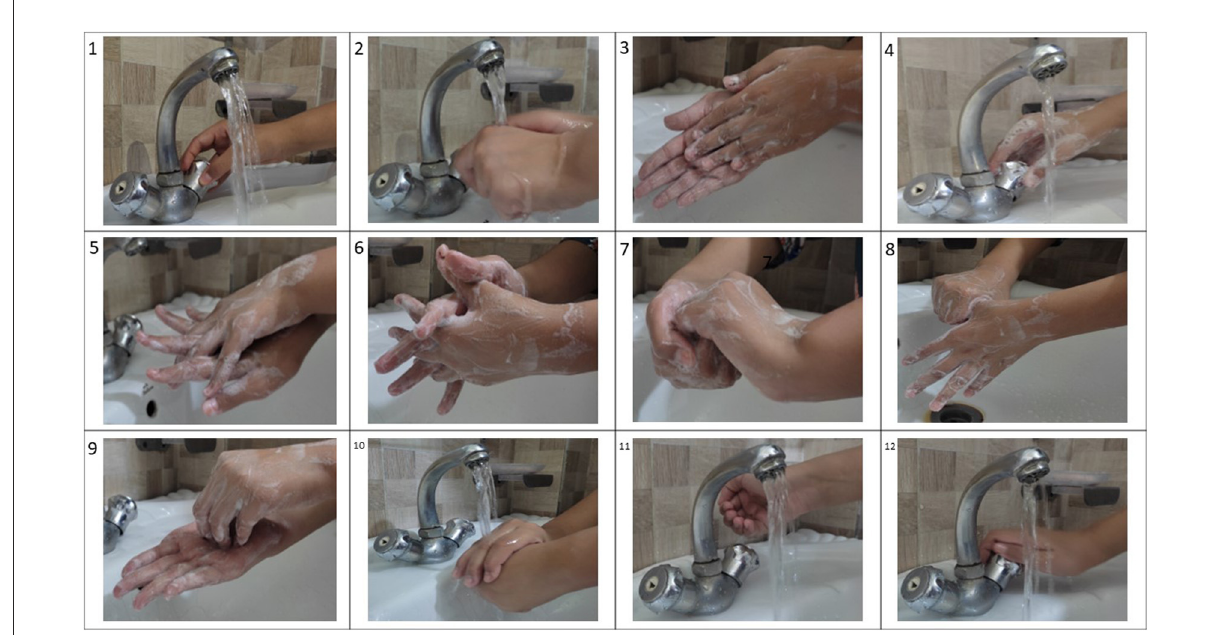
FIGURE1 The steps for the modified hand washing method: 1. open tap, 2. wet hands with water, 3. apply enough soap on hand and rub hands palm to palm to make enough foam, 4. close the tap using the foamed hand evenly applying the foam all over the tap handle/faucet, 5. rub the area of the hand by placing right palm over left dorsum with interlaced fingers and vice versa, 6. rub hands palm to palm with fingers interlaced, 7. rub back of fingers with opposing palms with fingers interlocked, 8. perform rotational rubbing of left thumb clasped in right palm and vice versa, 9. perform rotational rubbing, backward and forward with clasped fingers of the right hand in left palm and vice versa, 10. open the tap and rinse hands with water, 11. rinse the faucet with enough water to remove any foam on the faucet, 12. now close the tap with clean hands.